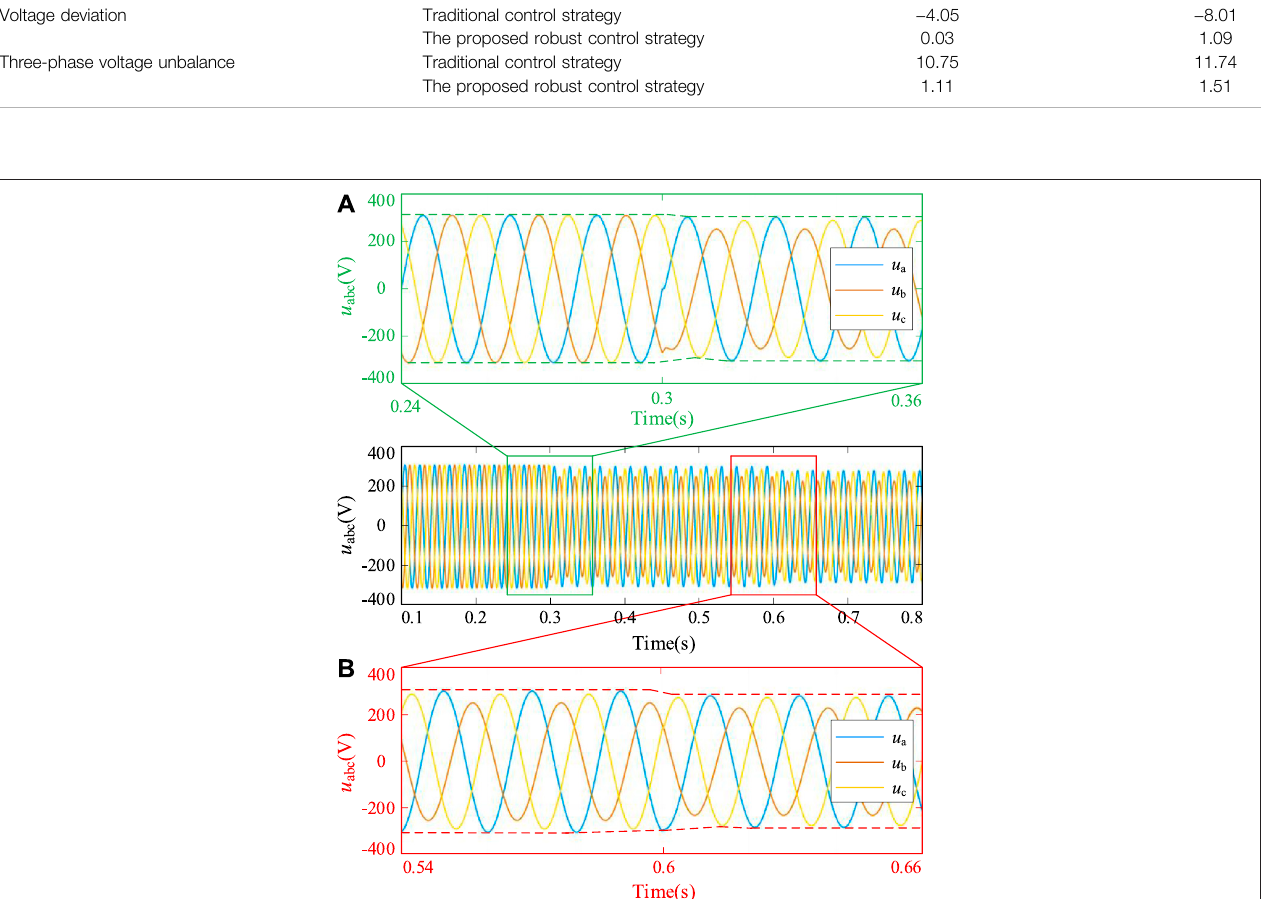
FIGURE 10 | Output voltage of the inverter under the traditional control strategy (three-phase unbalance). (A) Three-phase asymmetric load 1. (B) Three-phase asymmetric load